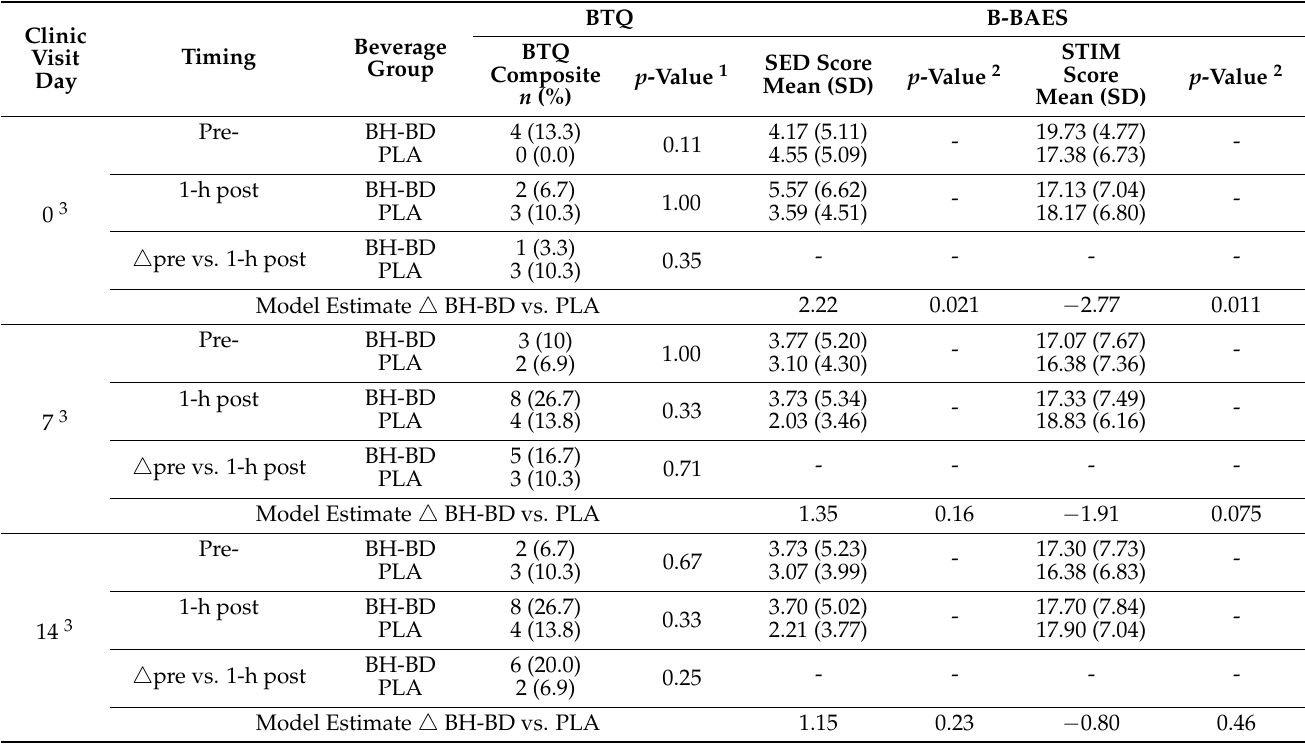
Table 4. BTQ composite score and B-BAES stimulation and sedation scores, prior to and 1-h post study beverage consump- tion during clinic visits on Days 0, 7, and